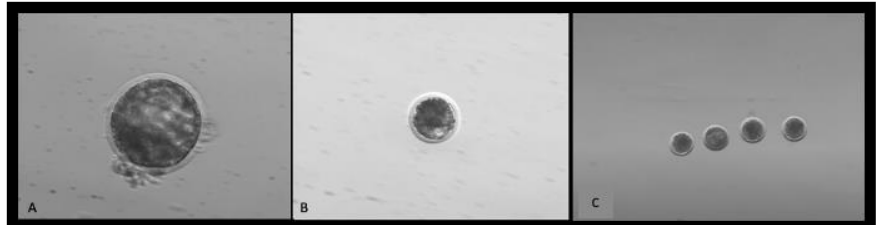
Figure 3. Still images of bovine embryos on different microscopy systems. ( A ) TE-300 Nikon inverted microscope, 400×; ( B ) SMZ-1000 stereo zoom microscope, 90×; ( C ) SMZ-1000 stereo zoom microscope, 90× 4 embryos in a group.